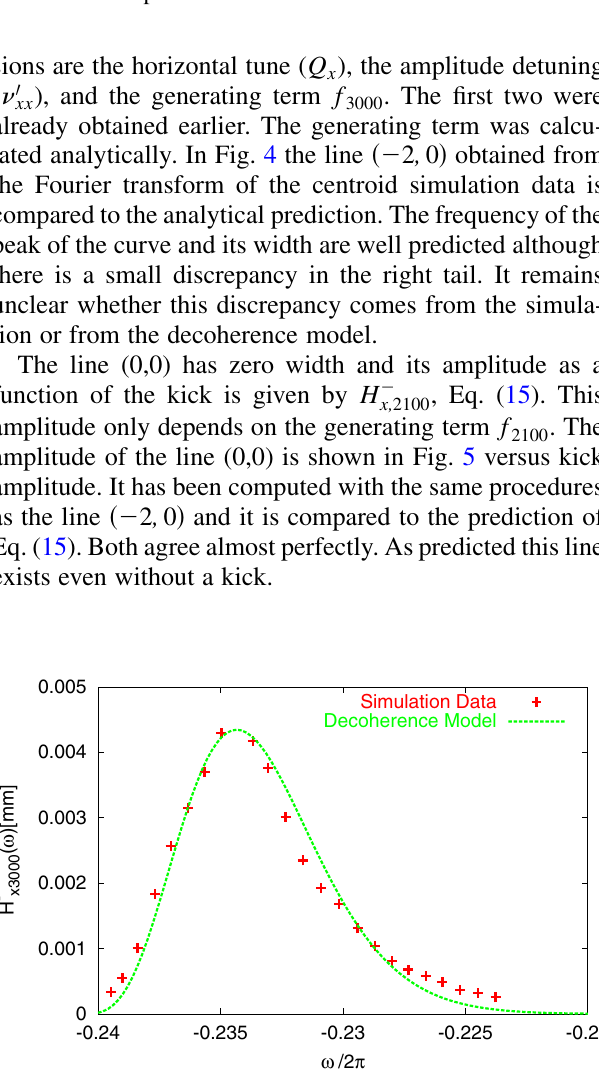
FIG. 2. (Color) FFT spectrum of the horizontal centroid motion of the beam for the SPS with extraction sextupoles